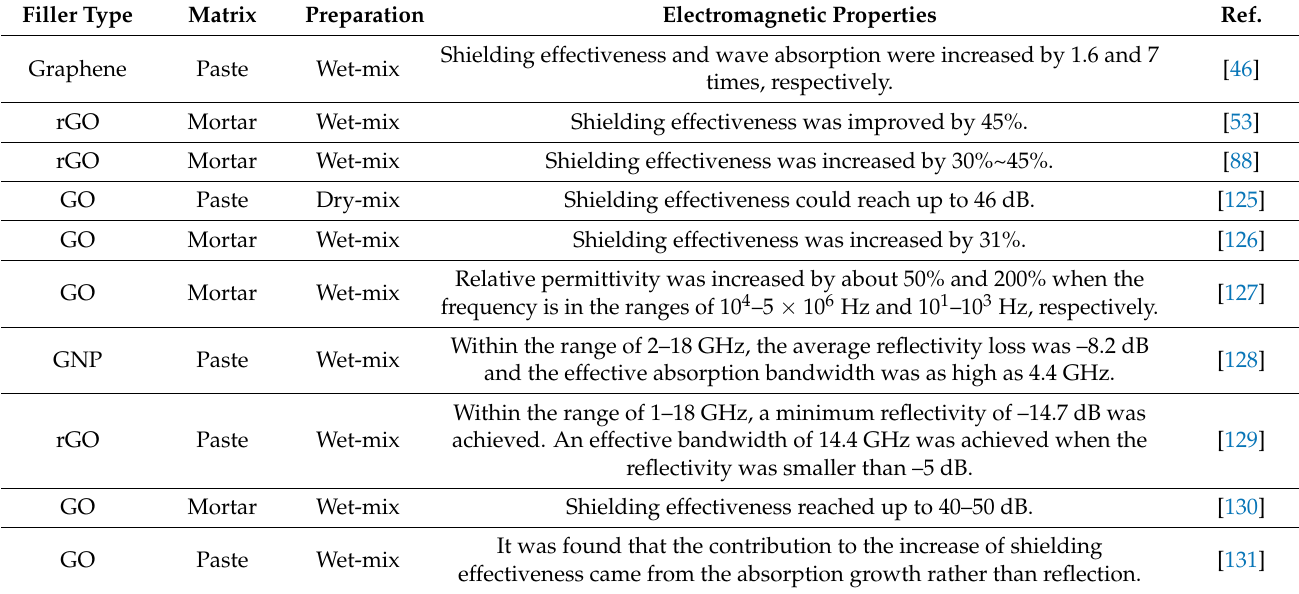
Table 5. Summary of studies on electromagnetic properties of